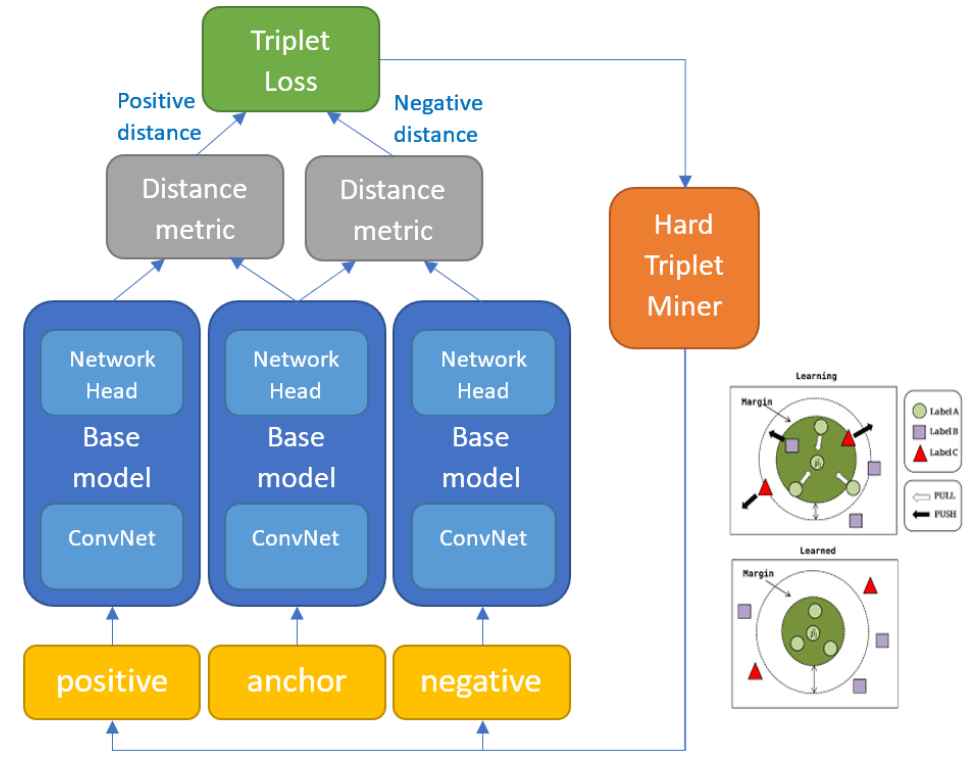
Figure 1. A triplet-based metric learning architecture. Each of the three samples is passed through the same embedding network, and the loss function determines how to space them apart in latent